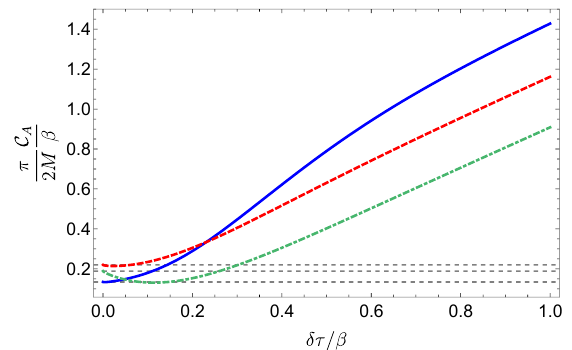
Figure 23 . Integrated complexity as a function of time for large hyperbolic black holes in d = 3 boundary dimensions for various values of the horizon radius | r h = 1 : 1 L (blue), r h = 1 : 5 L (dashed red), r h = 3 : 5 L (dot-dashed green). We see that it does not diverge at (cid:28) = (cid:28) c ( (cid:14)(cid:28) = 0). The value at (cid:14)(cid:28) = 0 has been set according to the complexity of formation, see [30].